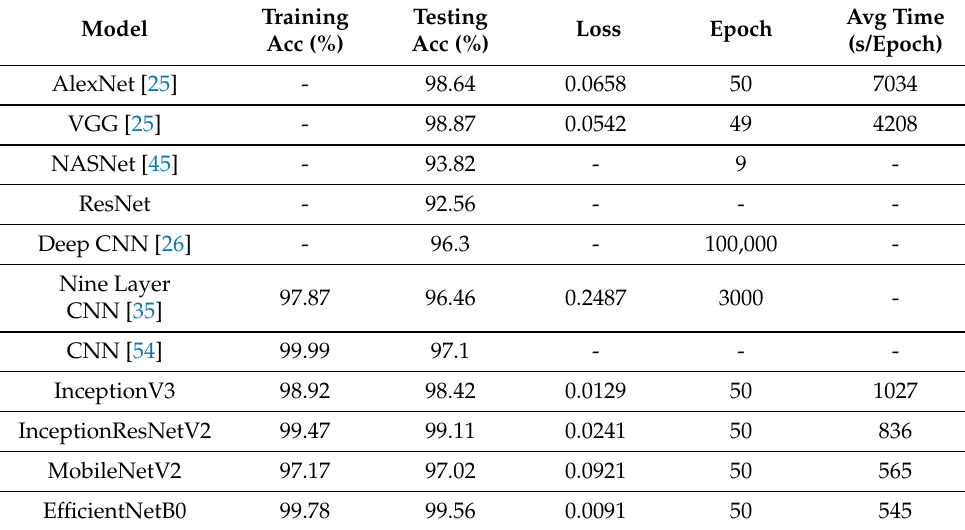
Table 8. Performance comparison of different DL